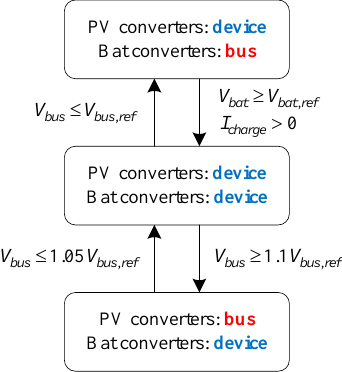
Figure 2. Diagram of the transitions between bus-regulating mode and device-regulating